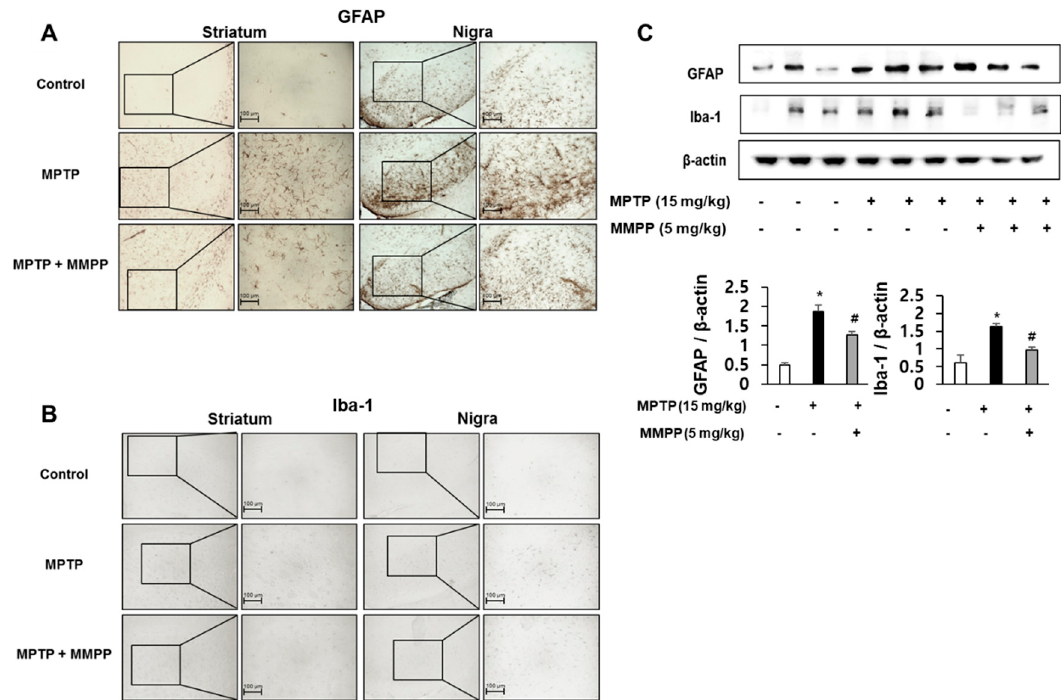
Figure 2. MMPP reduces glial fibrillary acidic protein (GFAP) and Iba-1 expression. The e ff ects of MMPP on reactive astrocytes and reactive microglial cells were measured by immunohistochemical analysis. Immunostaining for GFAP in the striatum and substantia nigra in 20 µ m-thick sections of mouse brains with specific primary antibodies and biotinylated secondary antibodies ( A ). Immunostaining of Iba-1 in the striatum and substantia nigra in 20 µ m-thick sections of mouse brains with specific primary antibodies and biotinylated secondary antibodies ( B ). The representative stained tissues were viewed with a microscope (50 × or 200 × magnification). ( C ) Expressions of GFAP and Iba-1 in the substantia nigra were measured by immunoblotting. Values are presented as mean ± SD from 10 mice. * p < 0.05, significant di ff erence from saline-injected mice; # p < 0.05, significant di ff erence between MPTP-injected groups.